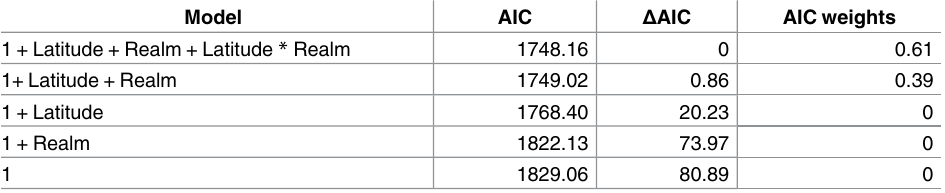
Table 3. Best models (GLMM) for the occurrence of cannibalism in the Northern